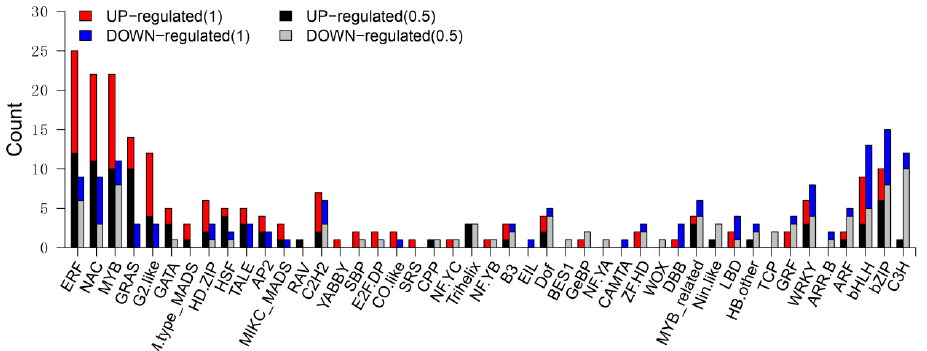
Figure 5. Distribution of differentially expressed TF genes between wild-type and mutant kernels. The graph shows the number of upregulated genes (log 2 (fold change) > 1 or log 2 (fold change) < − 1) in each family identified in the mutant (red) and wild-type (blue) and the number of upregulated genes (log 2 (fold change) > 0.5 or log 2 (fold change) < − 0.5) in each family identified in the mutant (black) and wild-type (gray). Agronomy 2020 , 10 , x FOR PEER REVIEW